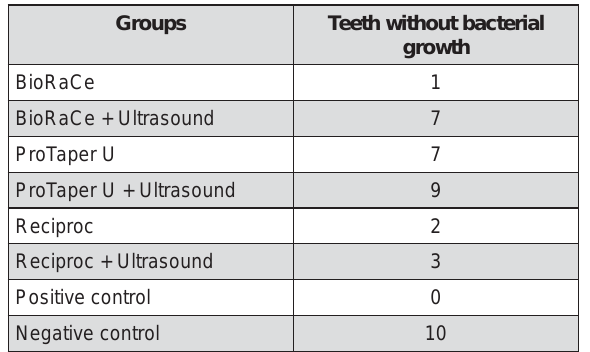
Figure 1- Number of teeth without bacterial growth for each group Table 1- Median, minimum and maximum CFU/mL after the biomechanical preparation of each group, with and without ultrasound. (cid:39)(cid:76)(cid:73)(cid:73)(cid:72)(cid:85)(cid:72)(cid:81)(cid:87)(cid:3)(cid:79)(cid:82)(cid:90)(cid:72)(cid:85)(cid:16)(cid:70)(cid:68)(cid:86)(cid:72)(cid:3)(cid:79)(cid:72)(cid:87)(cid:87)(cid:72)(cid:85)(cid:86)(cid:3)(cid:76)(cid:81)(cid:71)(cid:76)(cid:70)(cid:68)(cid:87)(cid:72)(cid:3)(cid:71)(cid:76)(cid:73)(cid:73)(cid:72)(cid:85)(cid:72)(cid:81)(cid:87)(cid:3)(cid:86)(cid:87)(cid:68)(cid:87)(cid:76)(cid:86)(cid:87)(cid:76)(cid:70)(cid:68)(cid:79)(cid:3)(cid:86)(cid:76)(cid:74)(cid:81)(cid:76)(cid:191)(cid:70)(cid:68)(cid:81)(cid:70)(cid:72)(cid:86)